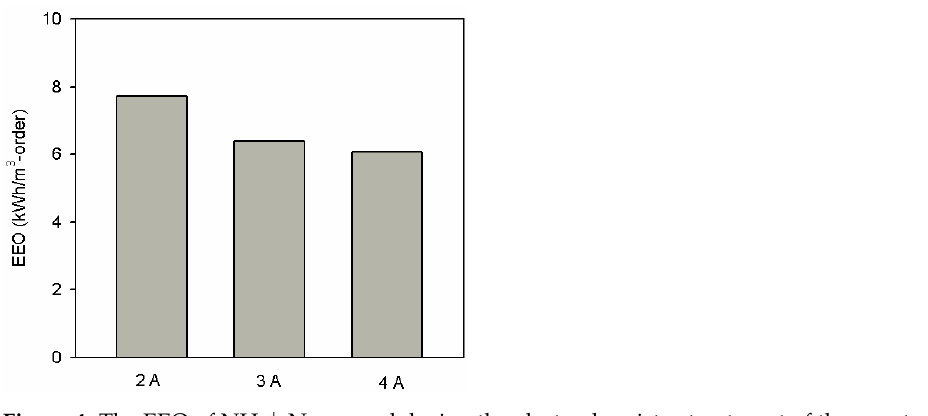
Table 1. Main water parameters of the spent caustic wastewater.